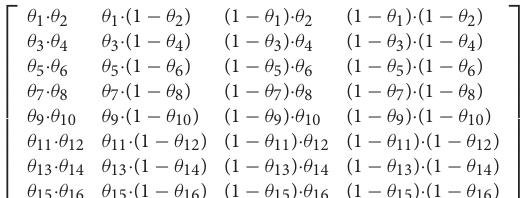
FIGURE 1 | Network